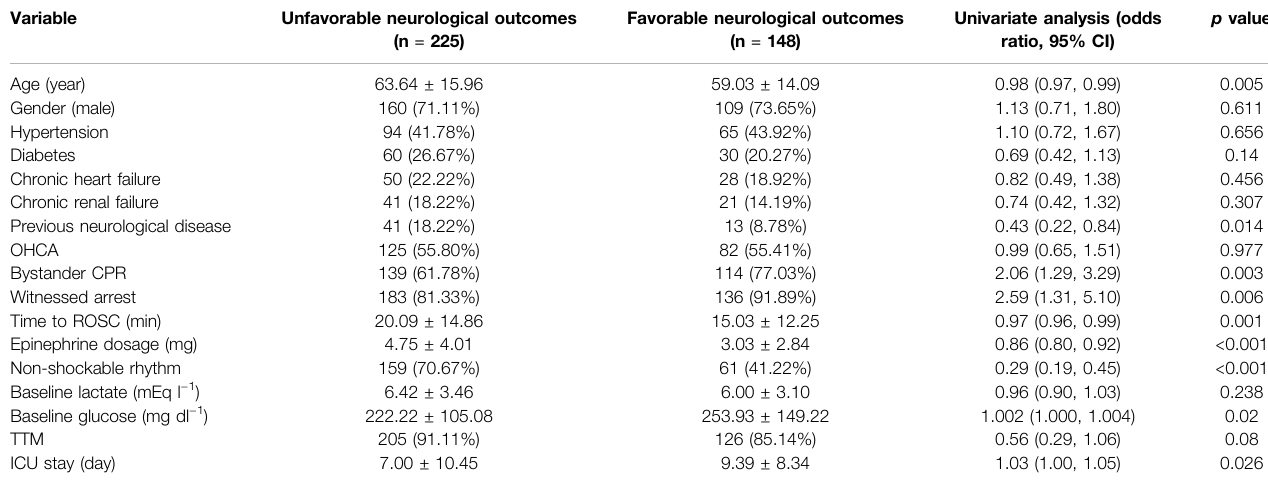
TABLE 2 | Univariate analysis for factors and their association with neurological outcomes three months after cardiac arrest.